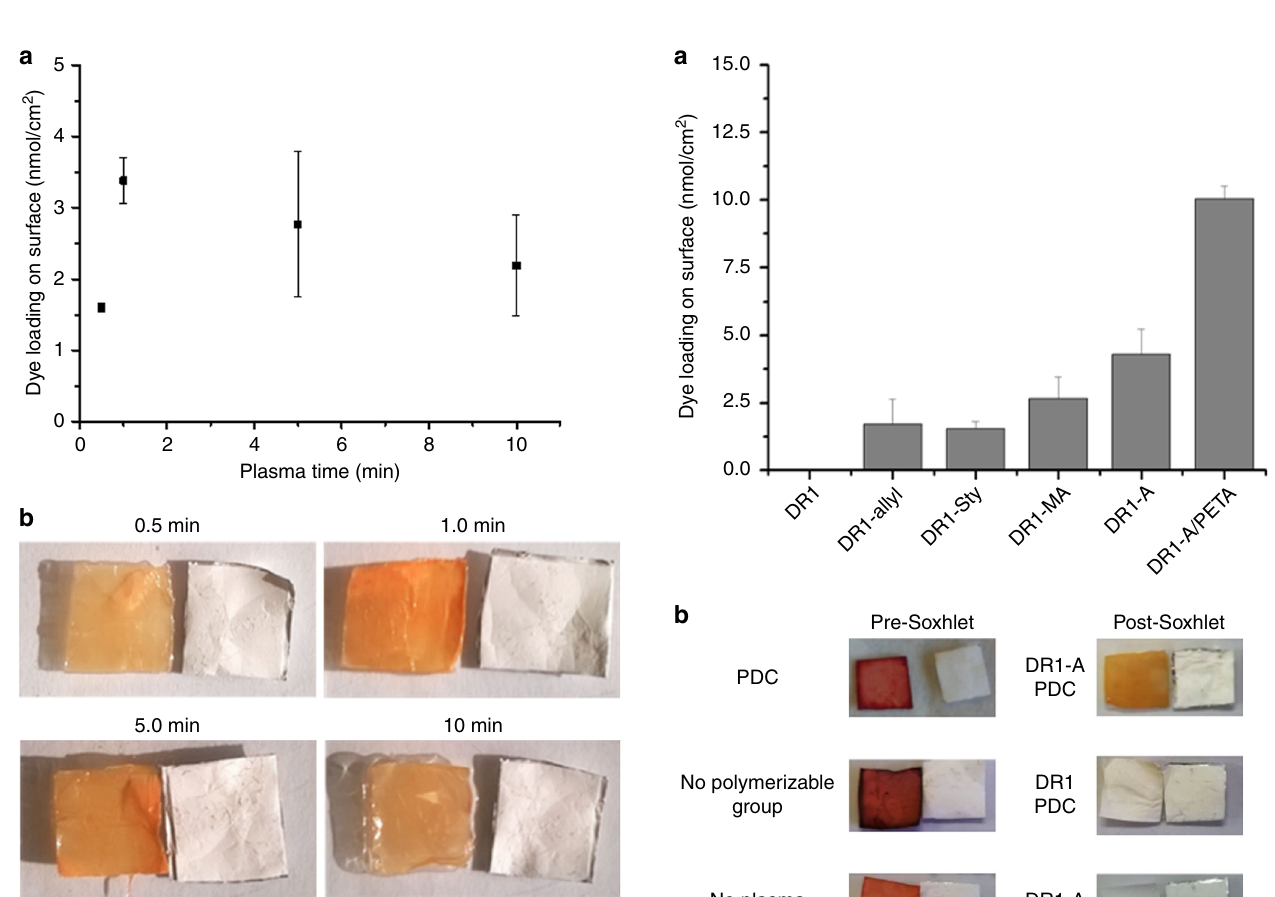
Fig. 3 Optimization of the plasma treatment time. a Dye loading on PA6 surface after PDC treatment measured by UV-VIS spectroscopy in 1/1 FA/AA in function of plasma treatment time on a single side of a 1-cm 2 piece of material in triplicate. b Pictures of wetted samples of PDC treated PA6 with DR1-A compared to untreated PA6 after soxhlet extraction for different plasma treatment times